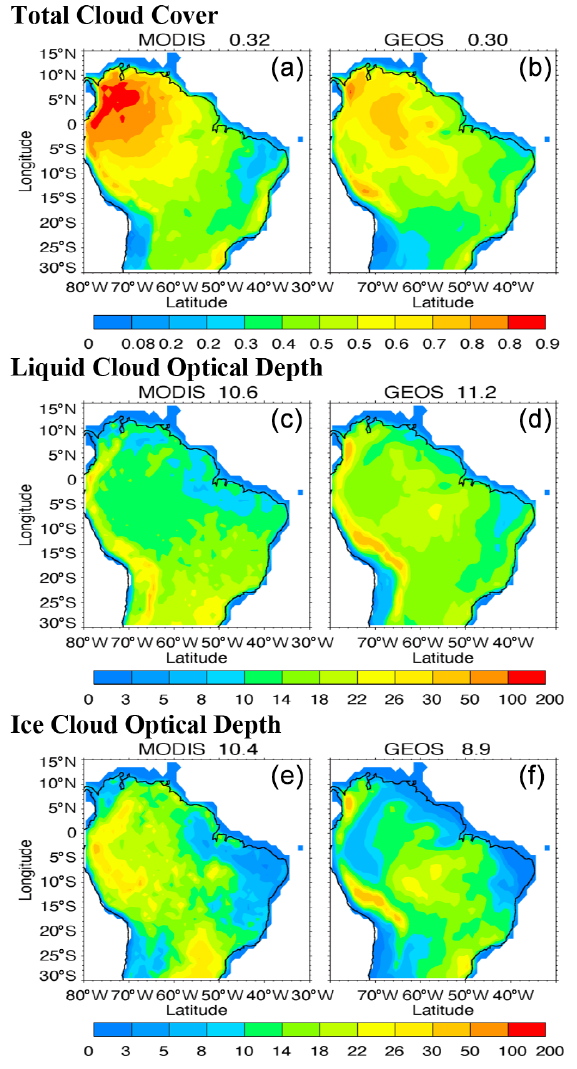
Figure 3. Multiyear seasonal (August–October 2010–2016) cloud field comparison between MODIS retrieved (a, c, e) and GEOS sim- ulated (b, d, f) , total cloud cover (a, b) , liquid cloud optical depth (c, d) , and ice cloud optical depth (e, f) .